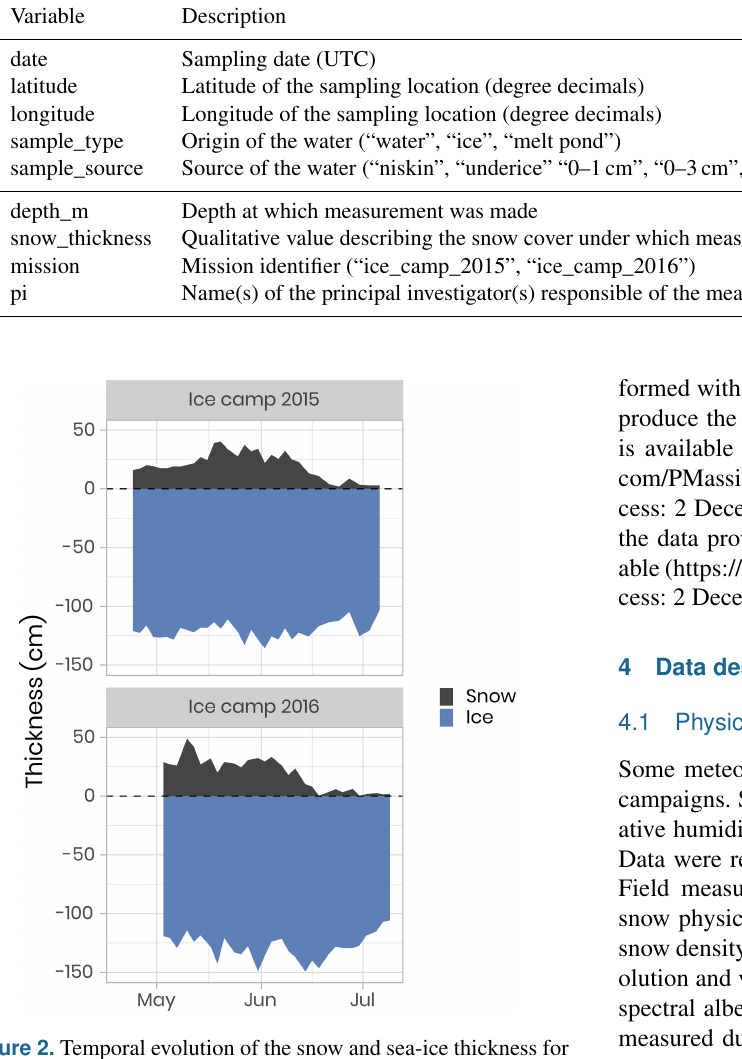
Figure 2. Temporal evolution of the snow and sea-ice thickness for both ice camp missions. The dashed horizontal line represents the snow–ice